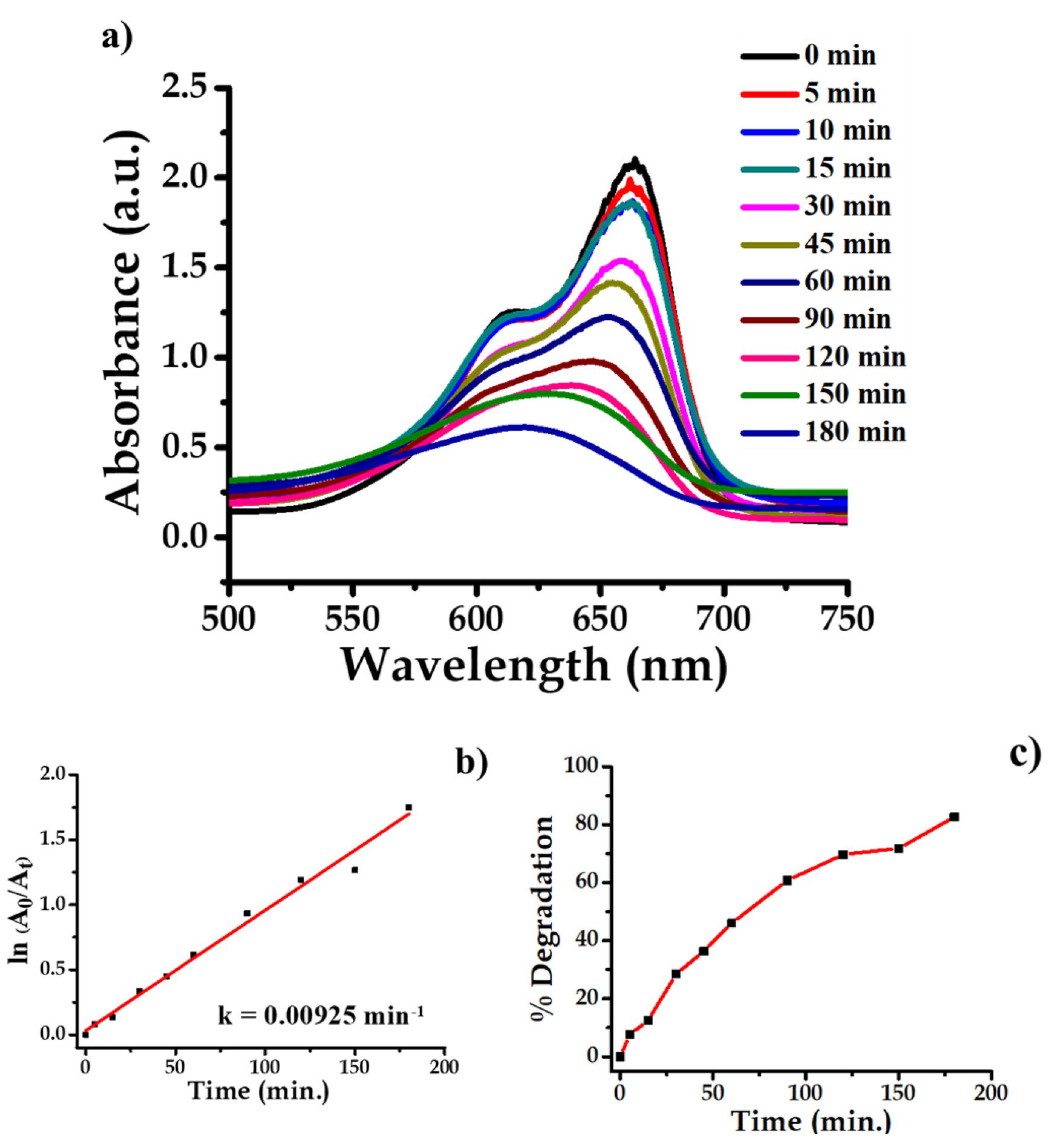
Figure 20. UV–Vis absorption spectra of ( a ) methylene blue, ( b ) kinetics of catalytic reduction and ( c ) percentage degradation of methylene